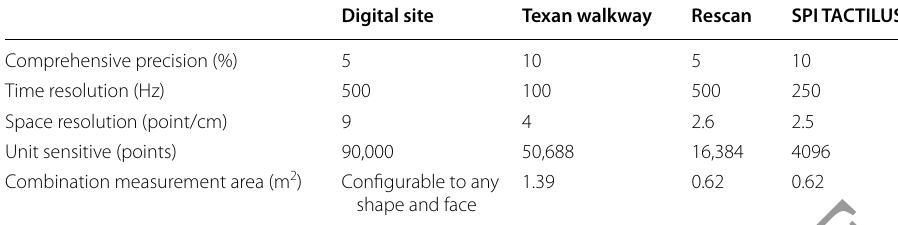
Table 1 Comparison of various gait tactile pressure technical